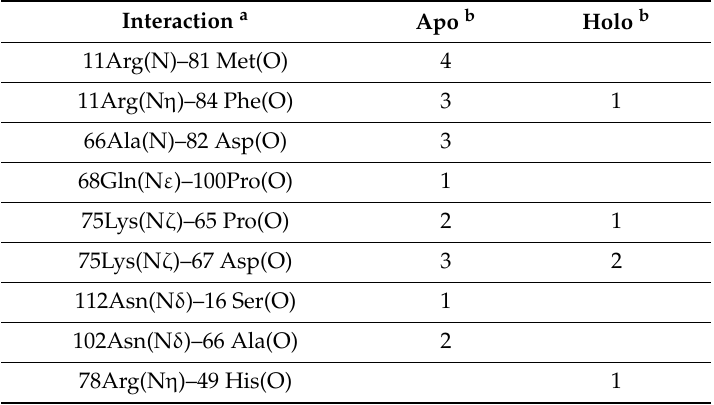
Table 3. Interdomain hydrogen-bond interactions. Interaction